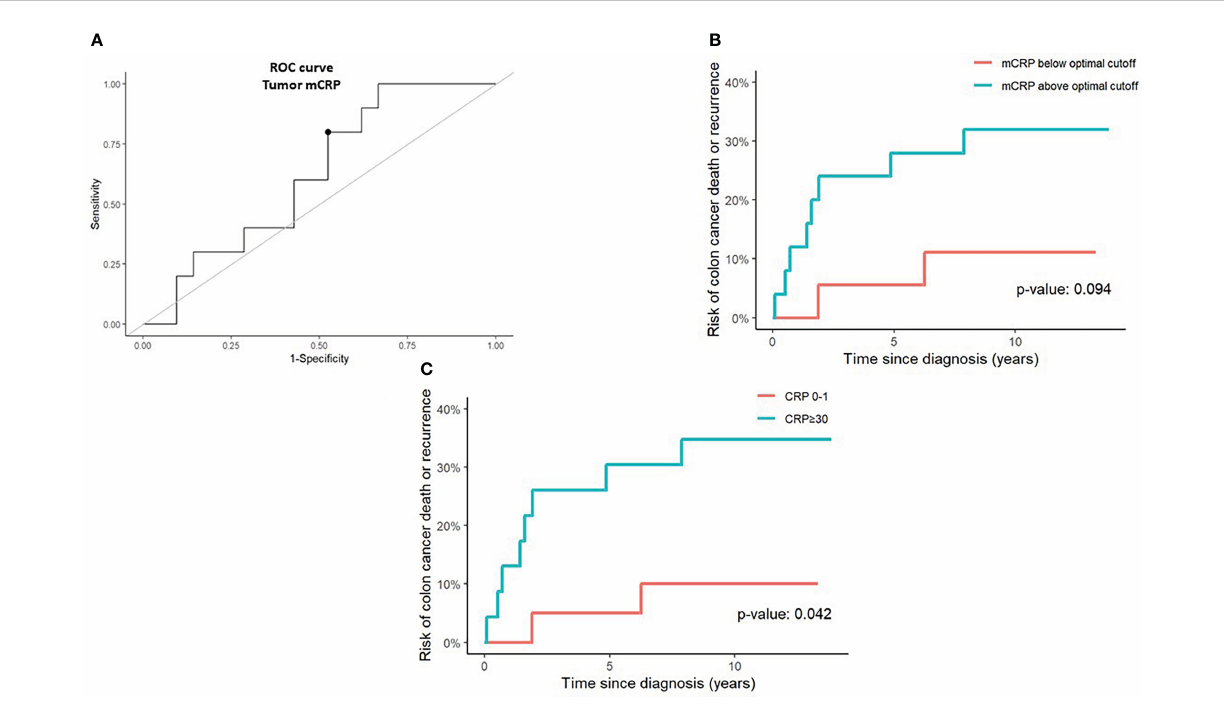
FIGURE 3 Prognostic value of tumor mCRP expression and serum CRP in colon cancer patients. (A) A receiver operating characteristics (ROC) curve was calculated to determine the optimal tumor mCRP cutoff value (marked by a bullet) de fi ned as the point on the curve with sensitivity and speci fi city closest to 100%, corresponding graphically to the point with the minimum distance to the upper left corner (B) Risk of colon cancer death or recurrence above and below the optimal tumor mCRP cutoff value identi fi ed from the ROC curve. (C) Risk of colon cancer death or recurrence in CRP-high (serum CRP >30 mg/L) and CRP-low (serum CRP 0-1 mg/L) patients. The optimal mCRP cutoff value was de fi